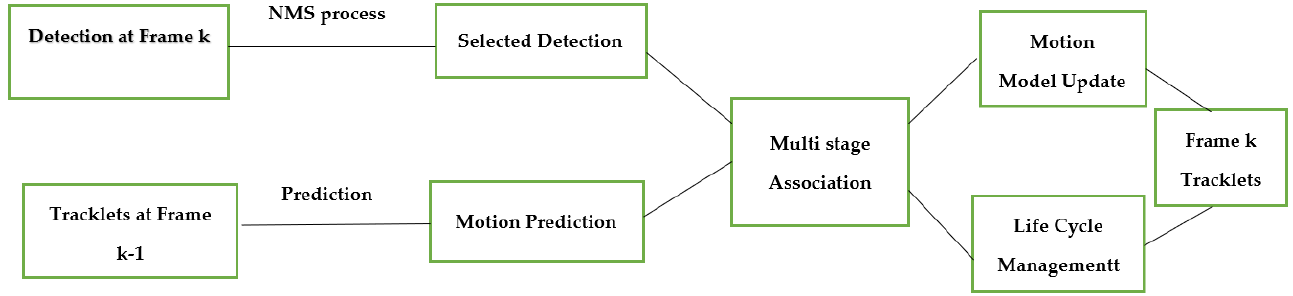
Figure 3. Vehicle tracklets bounding boxes. Figure 4. Motion prediction process.